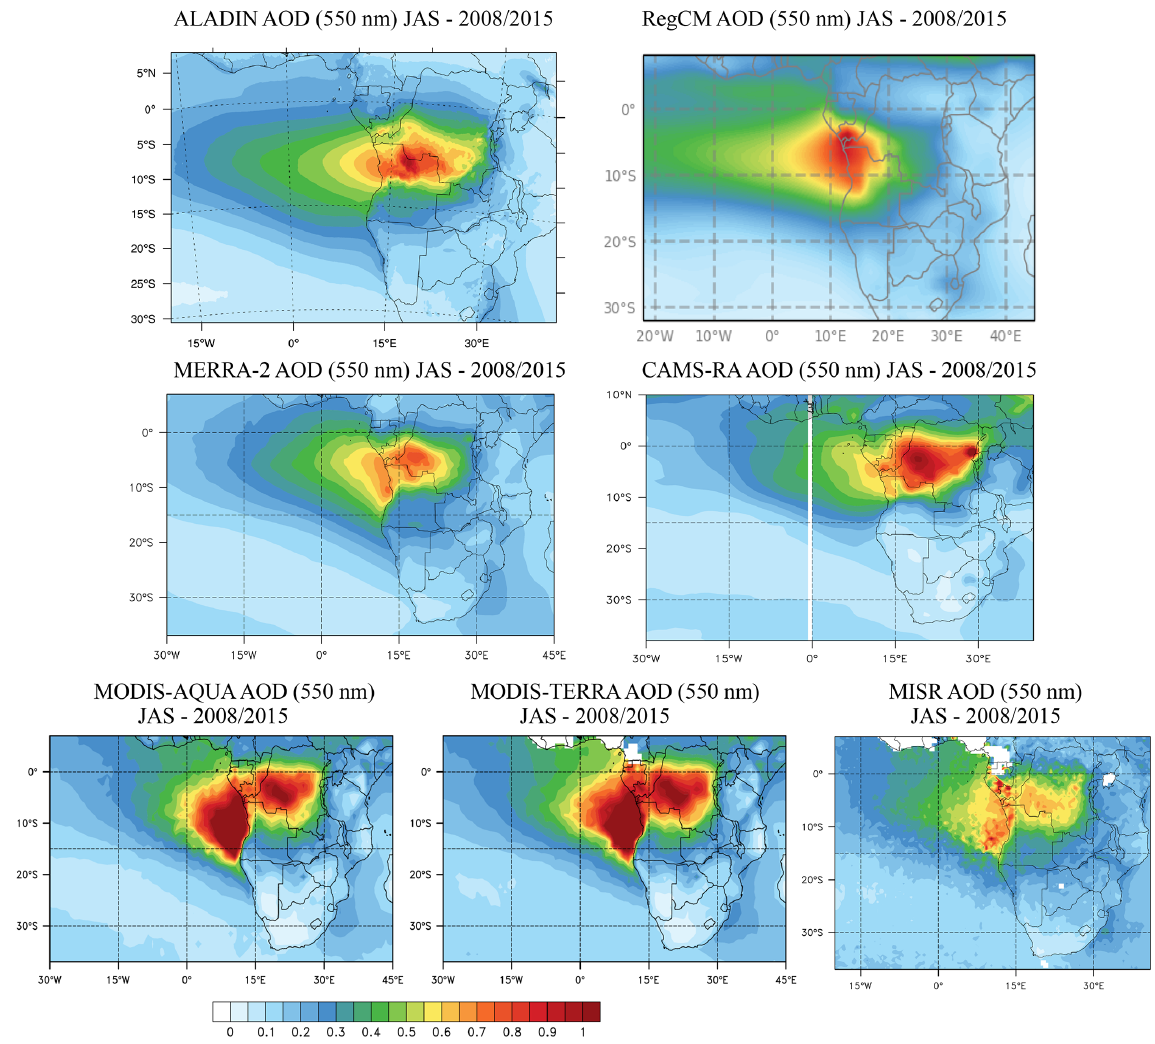
Figure 3. Total aerosol optical depth (AOD) estimated at 550nm by the two RCMs (ALADIN and RegCM for the CTL runs), two reanal- yses (CAMS-RA and MERRA-2) and two satellite products (standard MODIS and MISR AOD). The different period of observations and simulations are